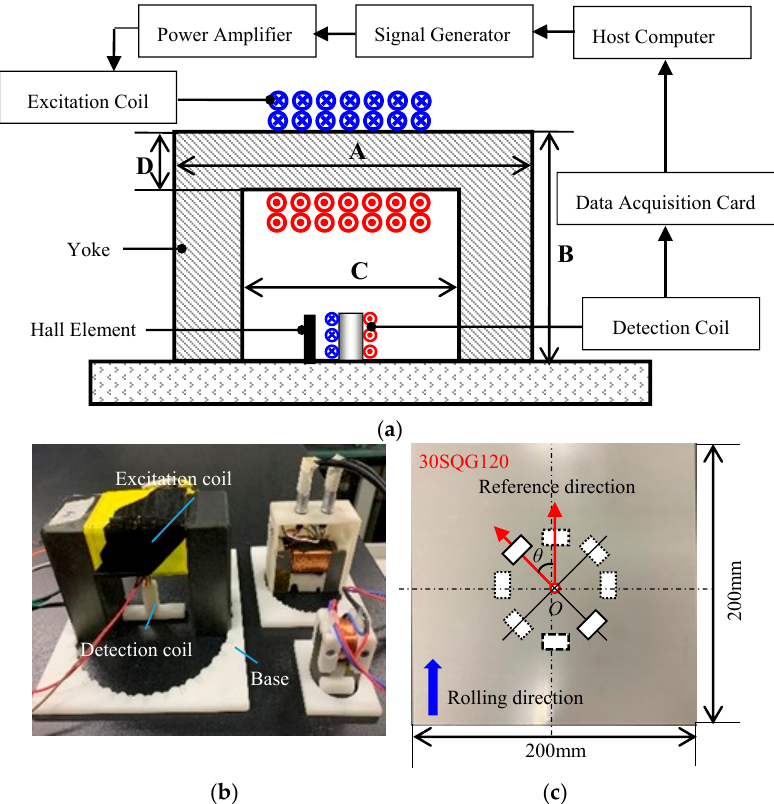
Figure 9. Experimental setup: ( a ) flow chart of the experimental system, ( b ) sensors, and ( c ) detection diagram.